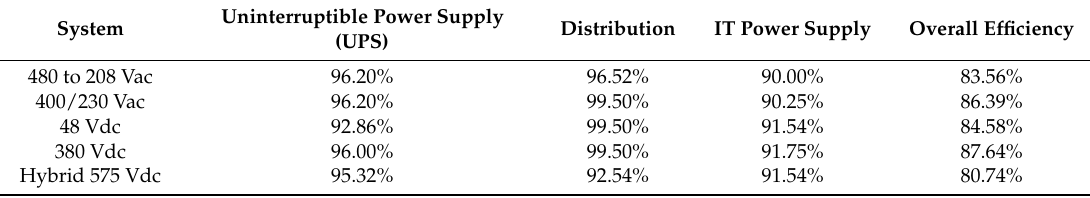
Table 3. Efficiency comparison of five distribution systems at 50% load